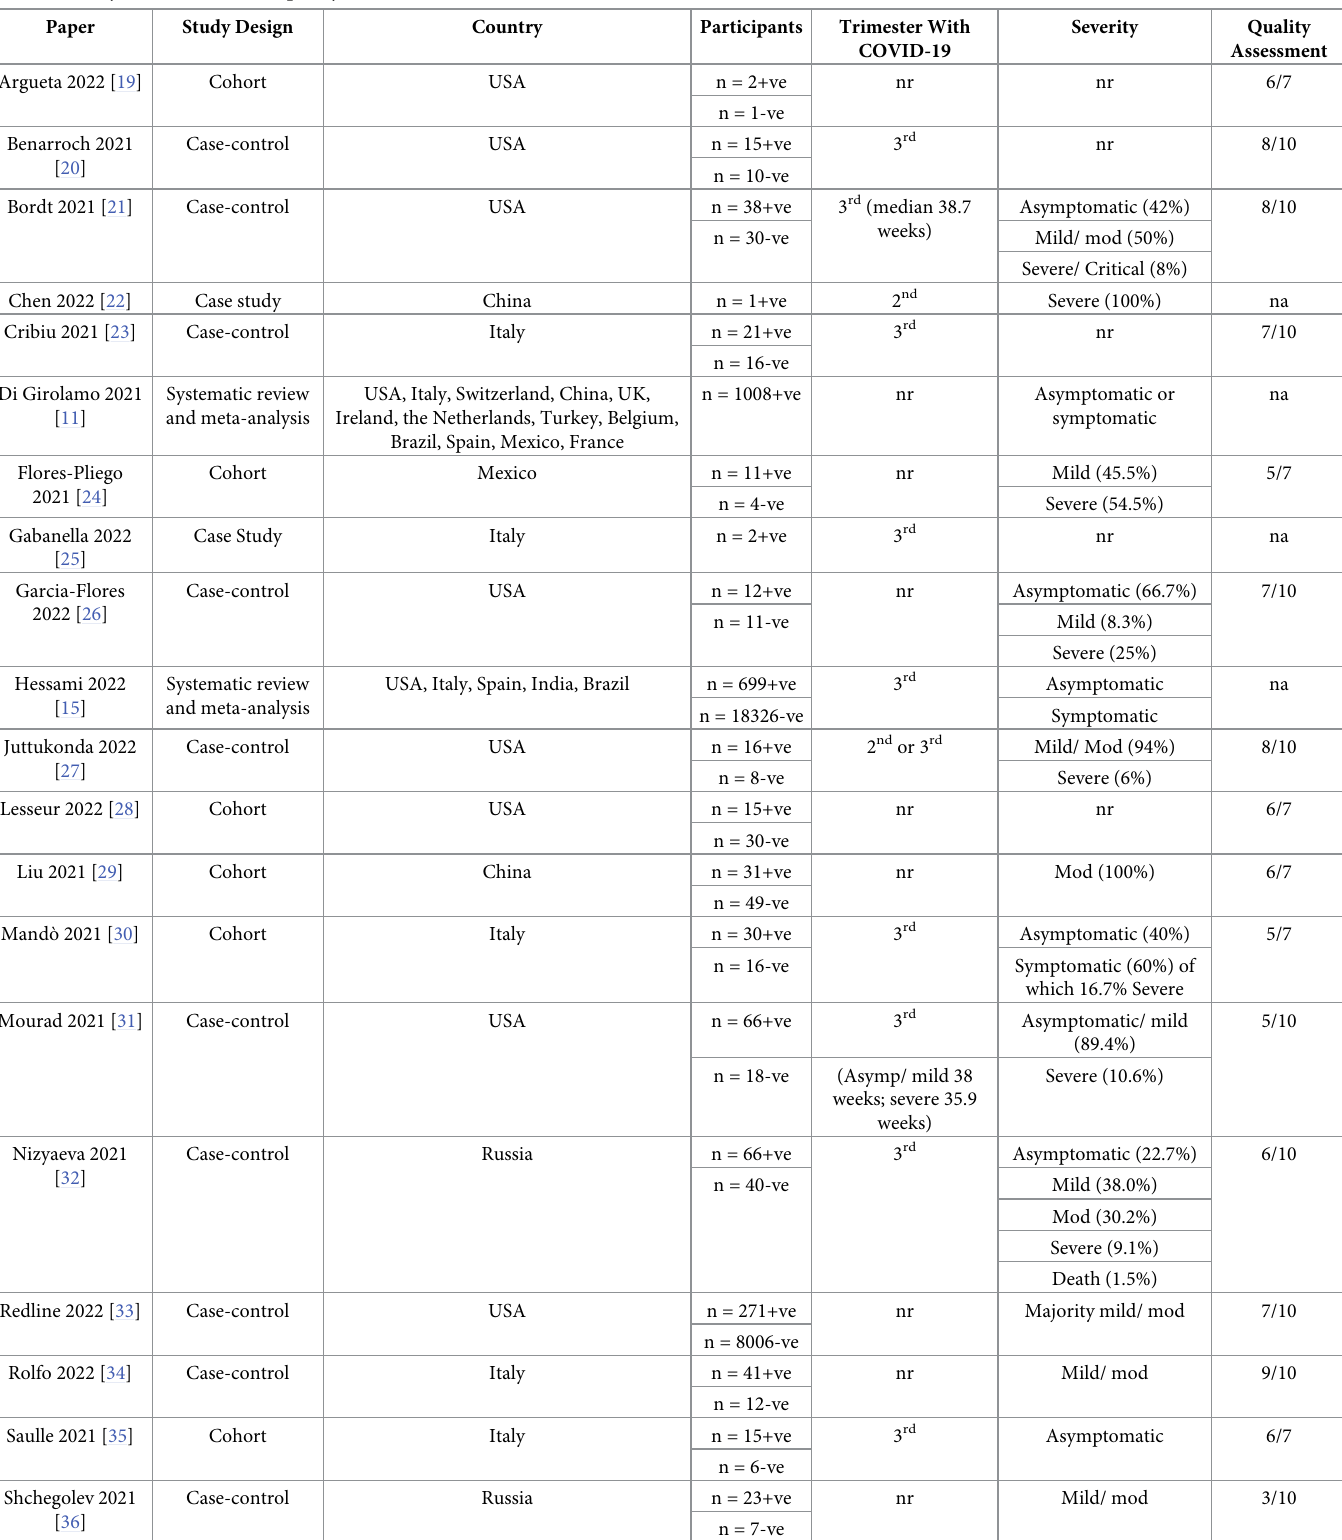
Table 2. Study characteristics and quality assessment of included